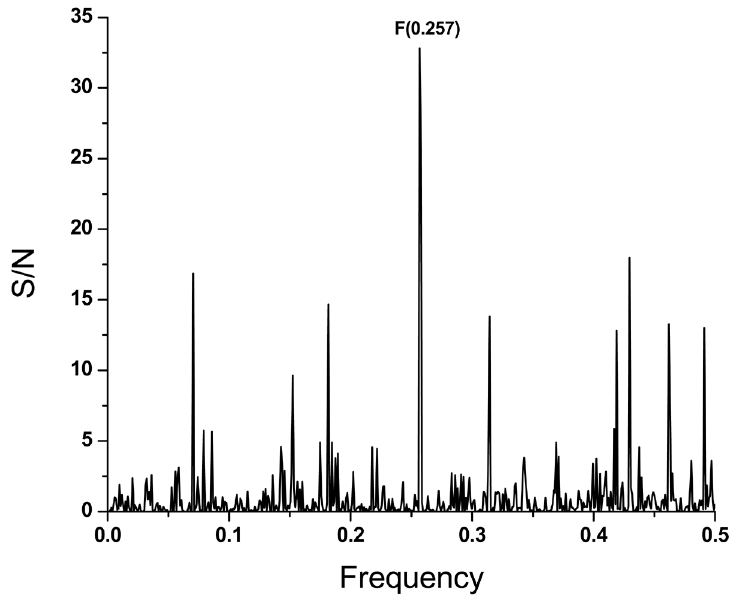
Figure 3. Cross-spectrum of ACE2 and S1 proteins from SARS-CoV and MERS-CoV. The abscissa and the ordinate are as described in Figure